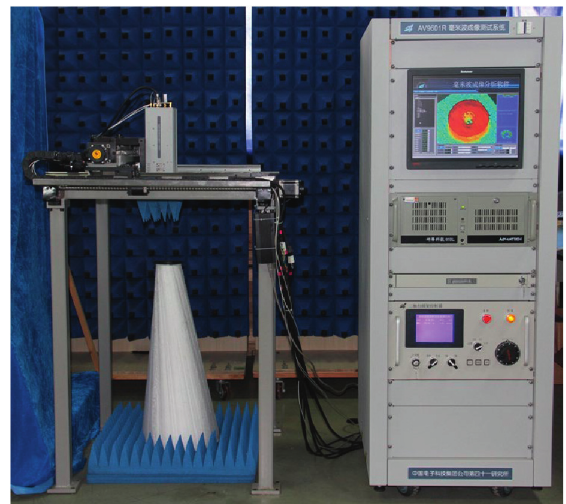
Figure 2: Picture of the developed THz FMCW imaging